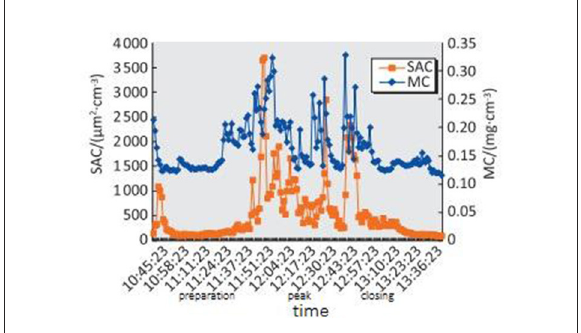
FIGURE3 Distribution of SAC 10 ∼ 500nm and MC 10 ∼ 500nm of particles at fried food posts in the Chinese kitchen in different time periods.